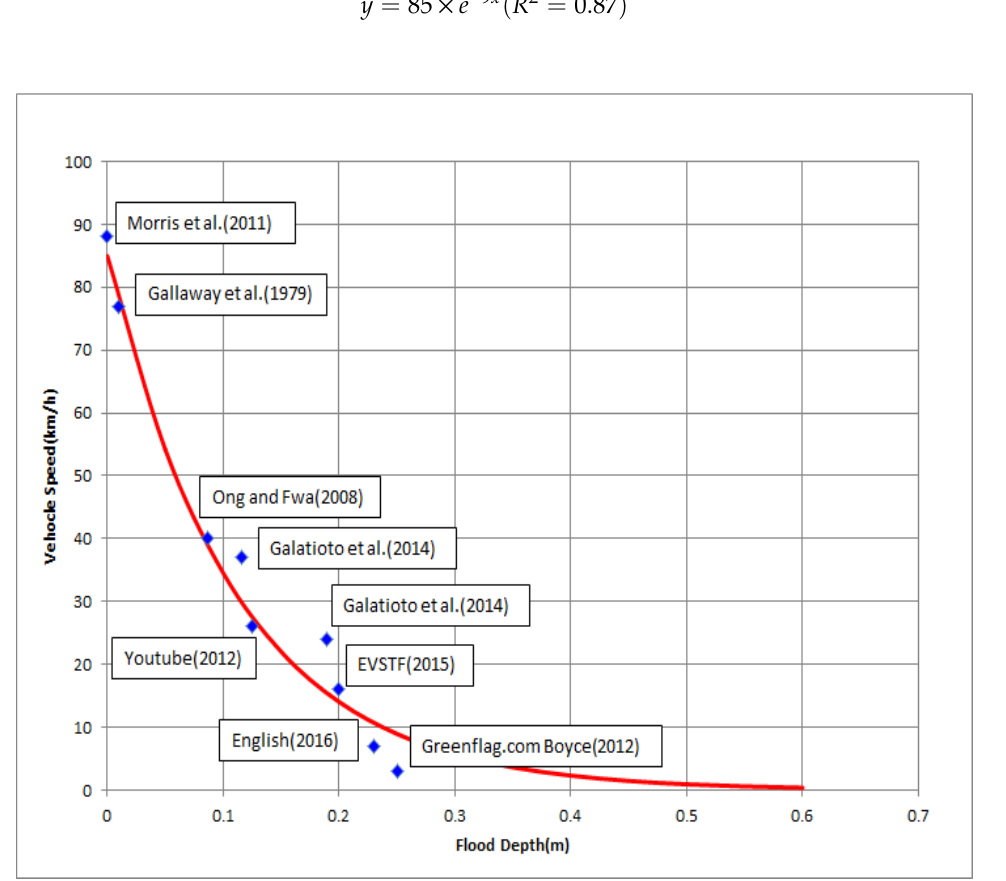
Figure 13. Estimation of depth – vehicle speed curve.